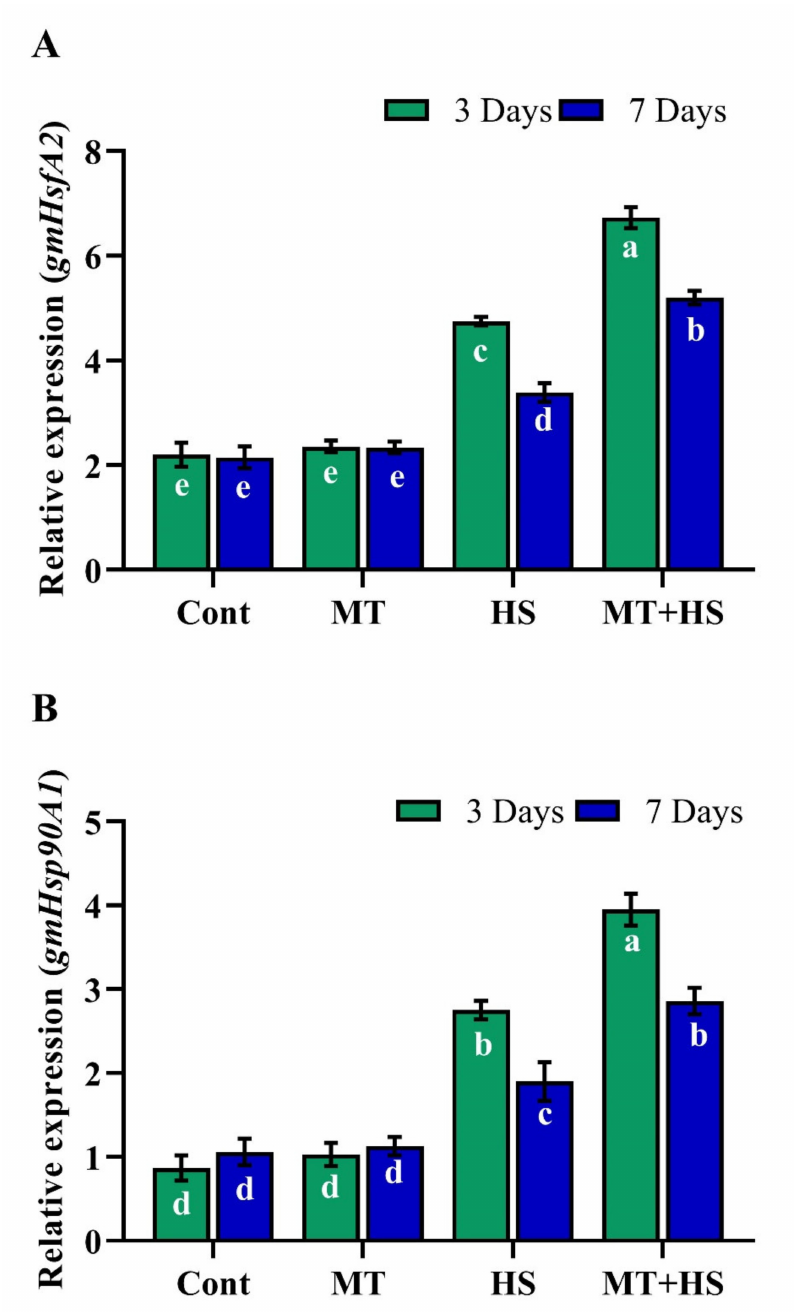
Figure 8. Effects of melatonin application with or without high temperature (42 ◦ C) on ( A ) relative expression of heat response transcript factor gmHsfA2 and ( B ) relative expression of heat shock protein gmHsp90 in soybean seedling after 3 and 7 days. Each data point is the mean of three replicates. Error bars represent the standard error of the mean. Bars with different letters are significantly different from each other by Duncan’s multiple range test at p ≤